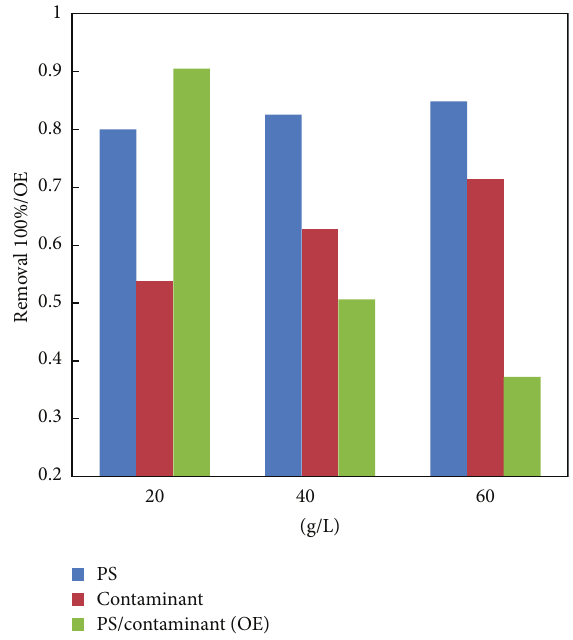
Figure 3: The decomposition of persulfate and contaminants after 72 h reaction time and the oxidant efficiency in the reactive